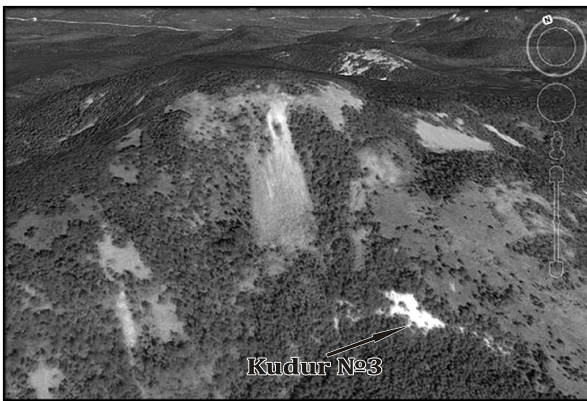
Figure 5. View of Mount Solontsovaya from the south (source: Google Maps). At the base of the mountain, kudur no. 3 (Bolshoi Shanduisky) appears as a white